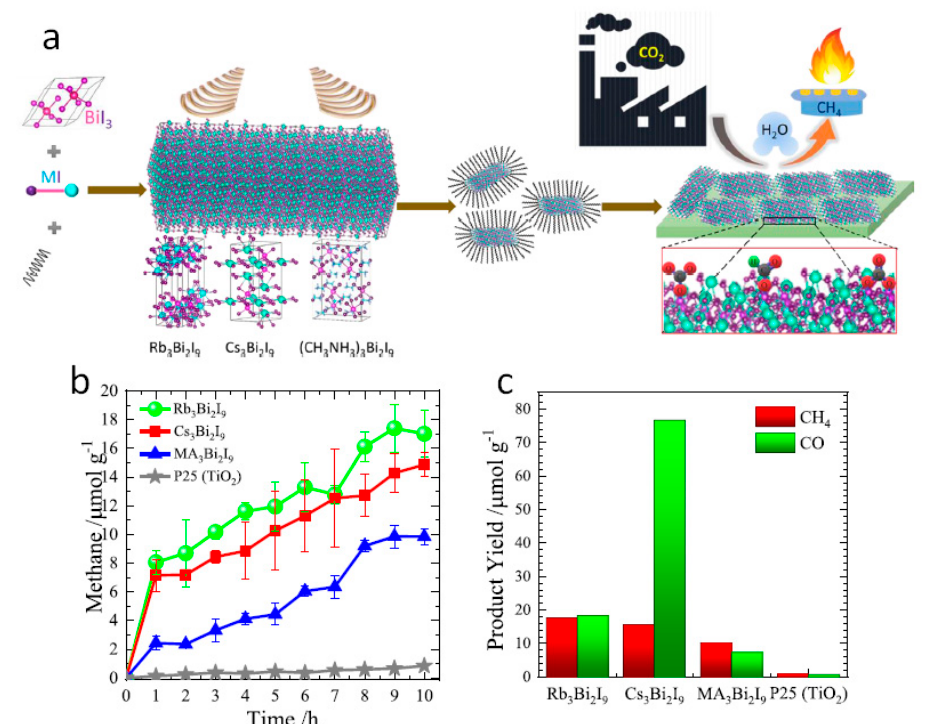
Figure 10. ( a ) Schematic illustration of the synthesis of Bi − based perovskites by top-down method, ( b ) Time − dependent CH 4 production in Bi − based perovskites, and ( c ) yields of CO and CH 4 production in different samples. Reproduced from [107], with permission from American Chemical Society, 2019.